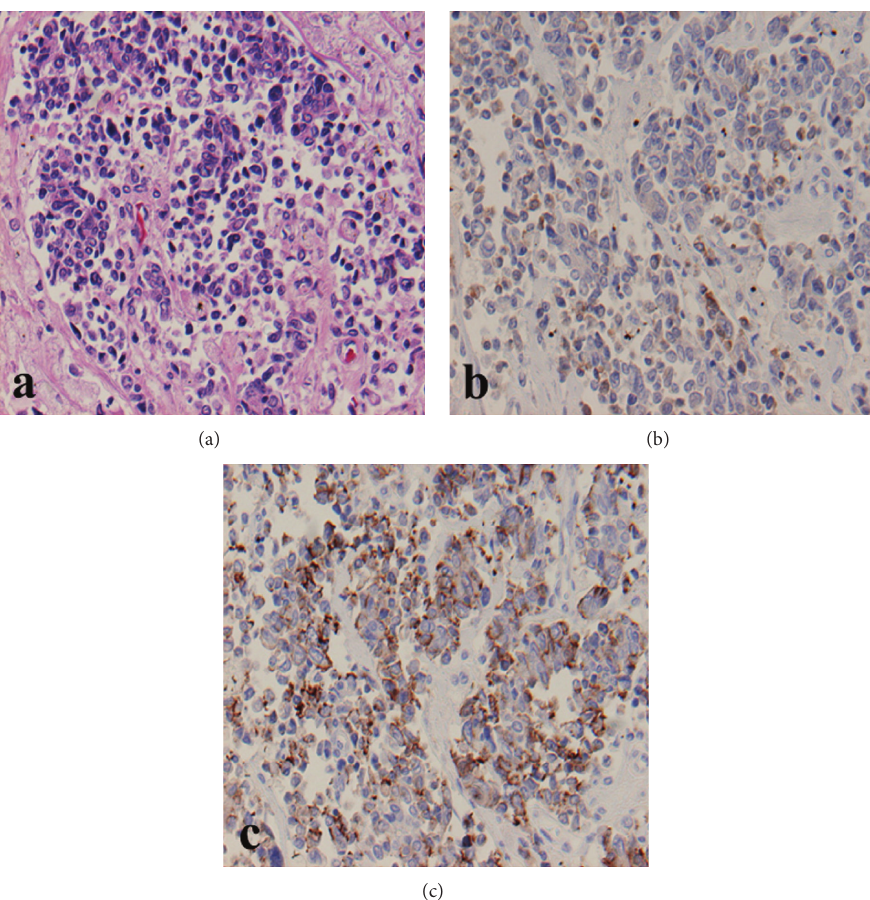
Figure 2: (a–c) Histopathology of the surgically resected spinal cord tumor, revealing a high nuclear/cytoplasmic ratio with necrosis. The sections were stained by hematoxylin and eosin (H&E) (a) following immunostaining with synaptophysin (b) and CD56 antibodies (c). Both synaptophysin- and CD56-positive cells were observed. The tumor was attributed to small-cell lung carcinoma metastasis. Original magnification ×